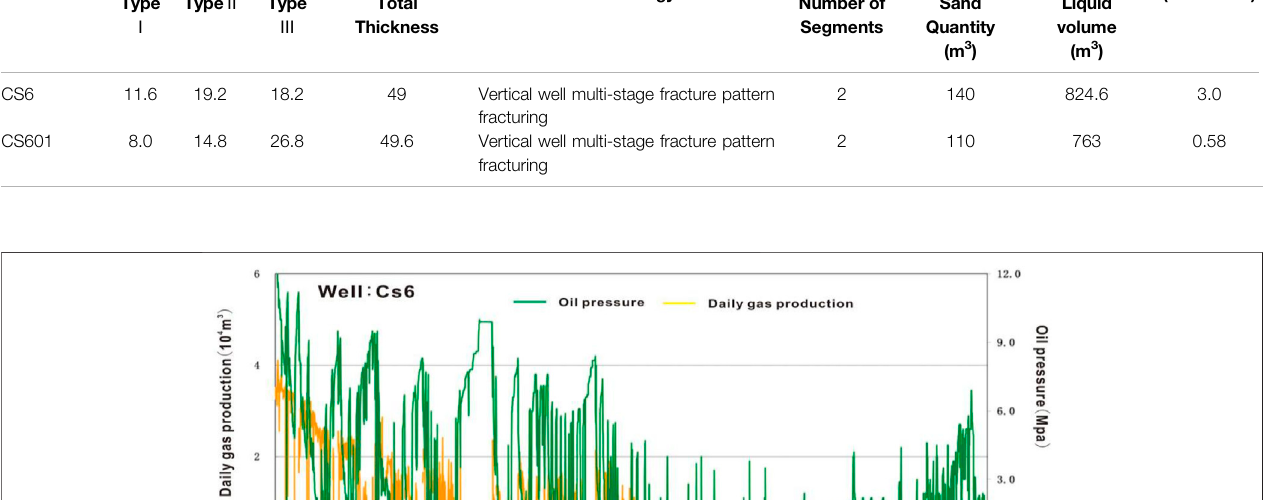
TABLE 5 | effective reservoir thickness, fracturing parameters, and process data table of Block CS6 in the Wangfu gas fi eld. Well